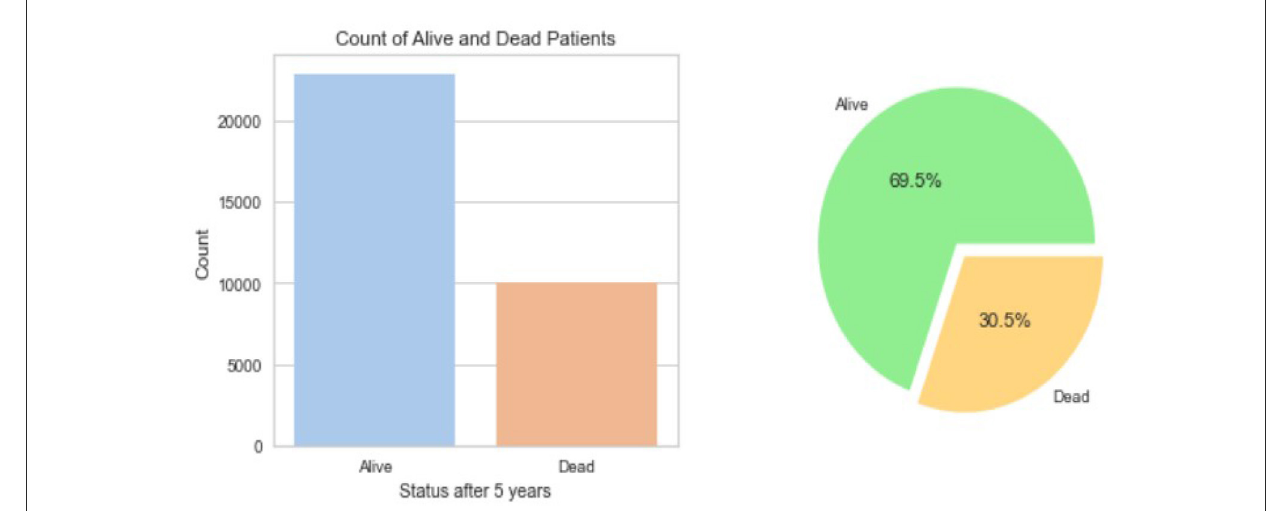
FIGURE1 Dataset balance.